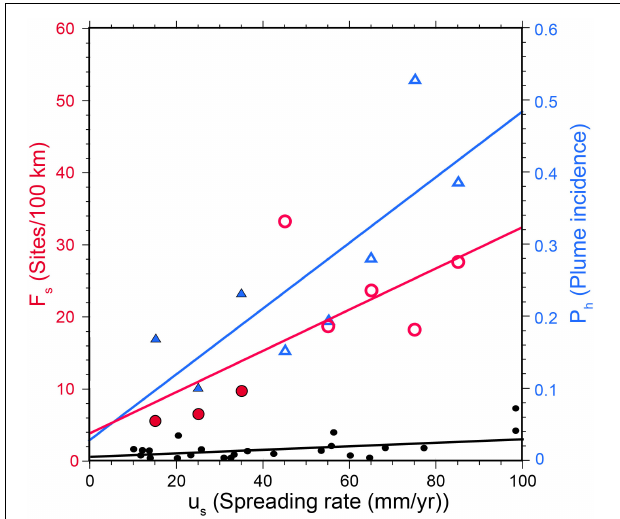
FIGURE 8 | Spreading rate ( u s ) versus relative hydrothermal activity ( F s , red circles; p h , blue triangles) in the Lau Basin (in 10 mm/year u s bins), and for a selection of 26 mid-ocean ridge sections (black circles) (mean u s for each section). Back-arc ridges in the NE Lau Basin (this paper) shown as solid red and blue symbols, VFR/ELSC ridge (Martinez et al., 2006) shown as open red and blue symbols. Ridge data (Beaulieu et al., 2015) are F s only. Corresponding regression equations (solid lines) are: Lau F s : F s = 3.7 + 0.29 u s , r = 0.69; Lau p h : p h = 2.7 + 0.46 u s , r = 0.80; Mid-ocean ridge F s : F s = 0.61 + 0.025 u s , r =